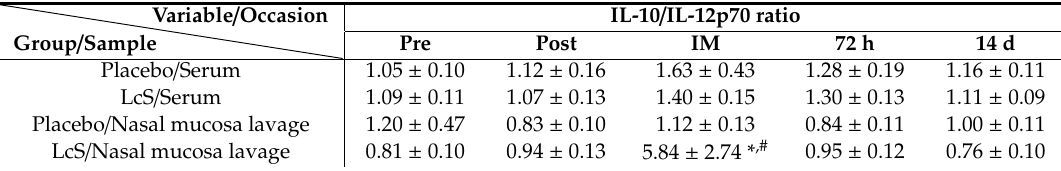
Table 3. Ratio of IL-10 and IL-12p70 (IL-10 / IL-12p70) in the serum and nasal mucosa lavage of the study volunteers separated into groups LcS and placebo obtained in five di ff erent occasions (Pre, Post, IM.